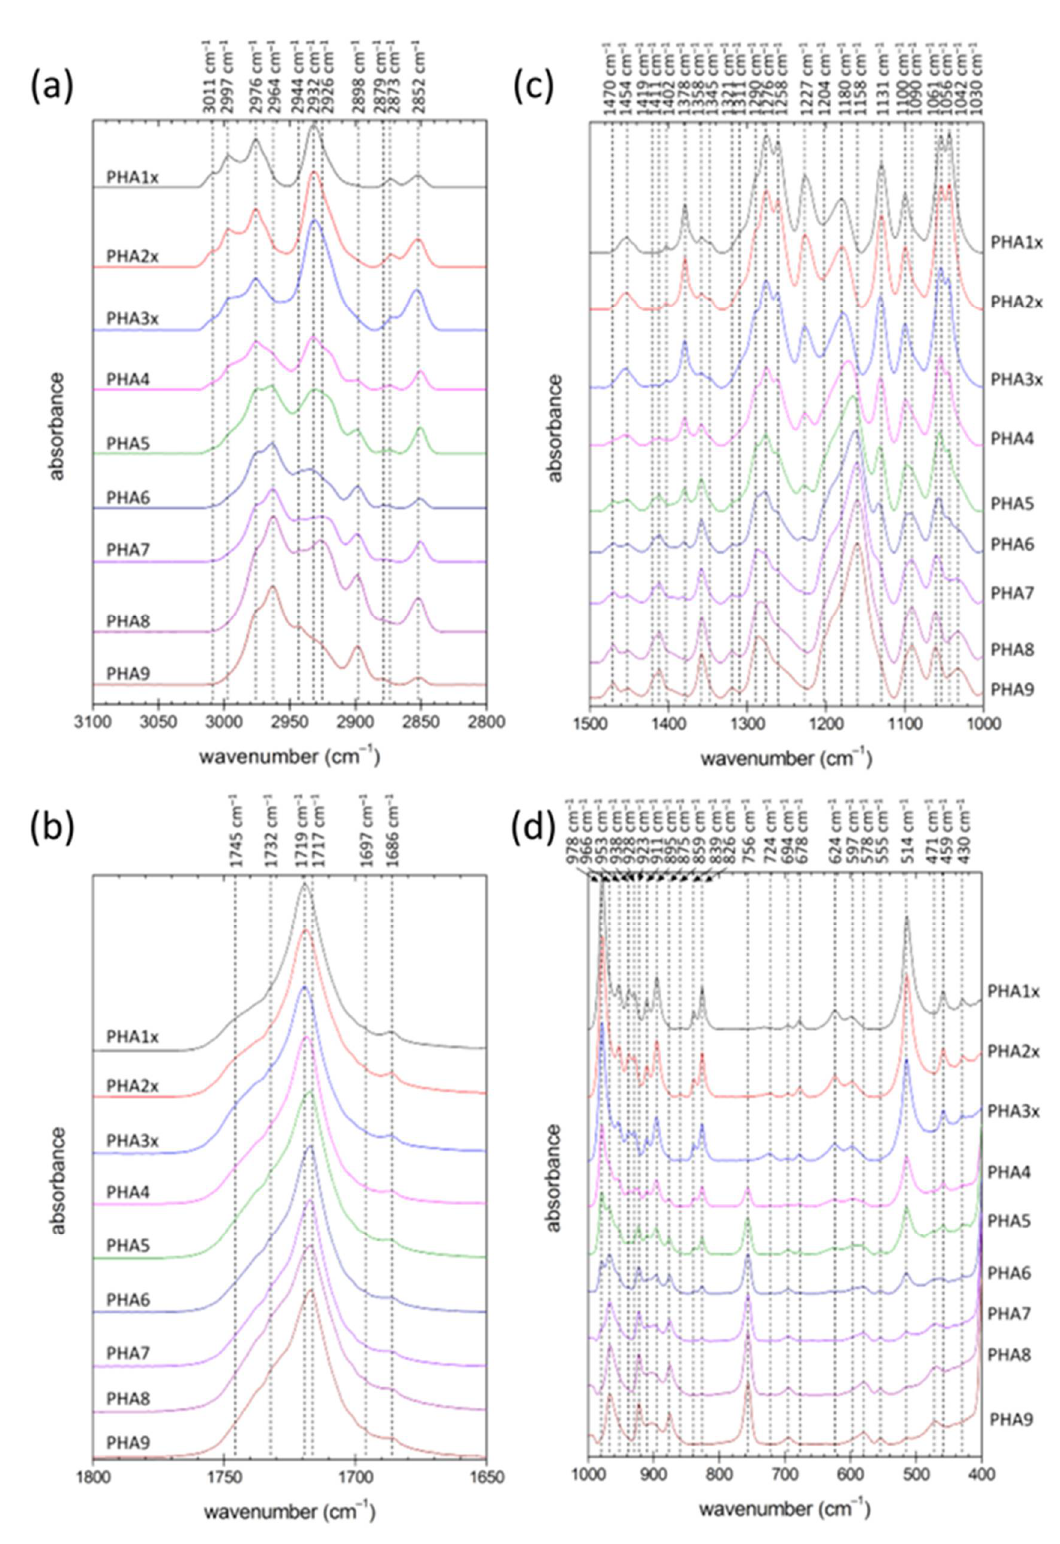
Figure 1. Normalized ATR FTIR spectra (cut-offs for the analytically important spectral regions) of the solution-casted PHA films prepared from polymers with different monomer composition (each spectrum represents an arithmetic average of 10 individual spectra collected at different locations on the surface of the film). Frequencies of the absorption band maxima were determined from the second derivative of the spectra.